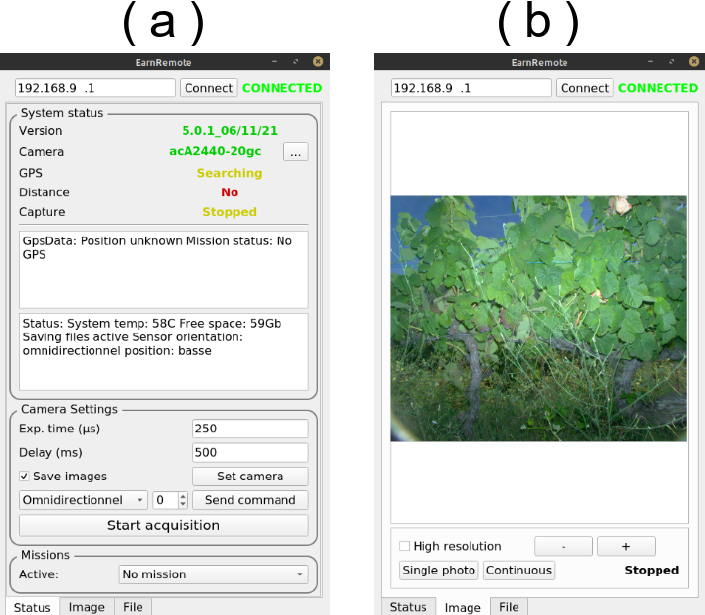
Figure 4. Screenshots of the in-house Android smartphone application used to control and monitor the sensor. ( a ) Connection and settings. ( b ) Picture quality preview. Overexposed or underexposed parts of the picture are highlighted in red when